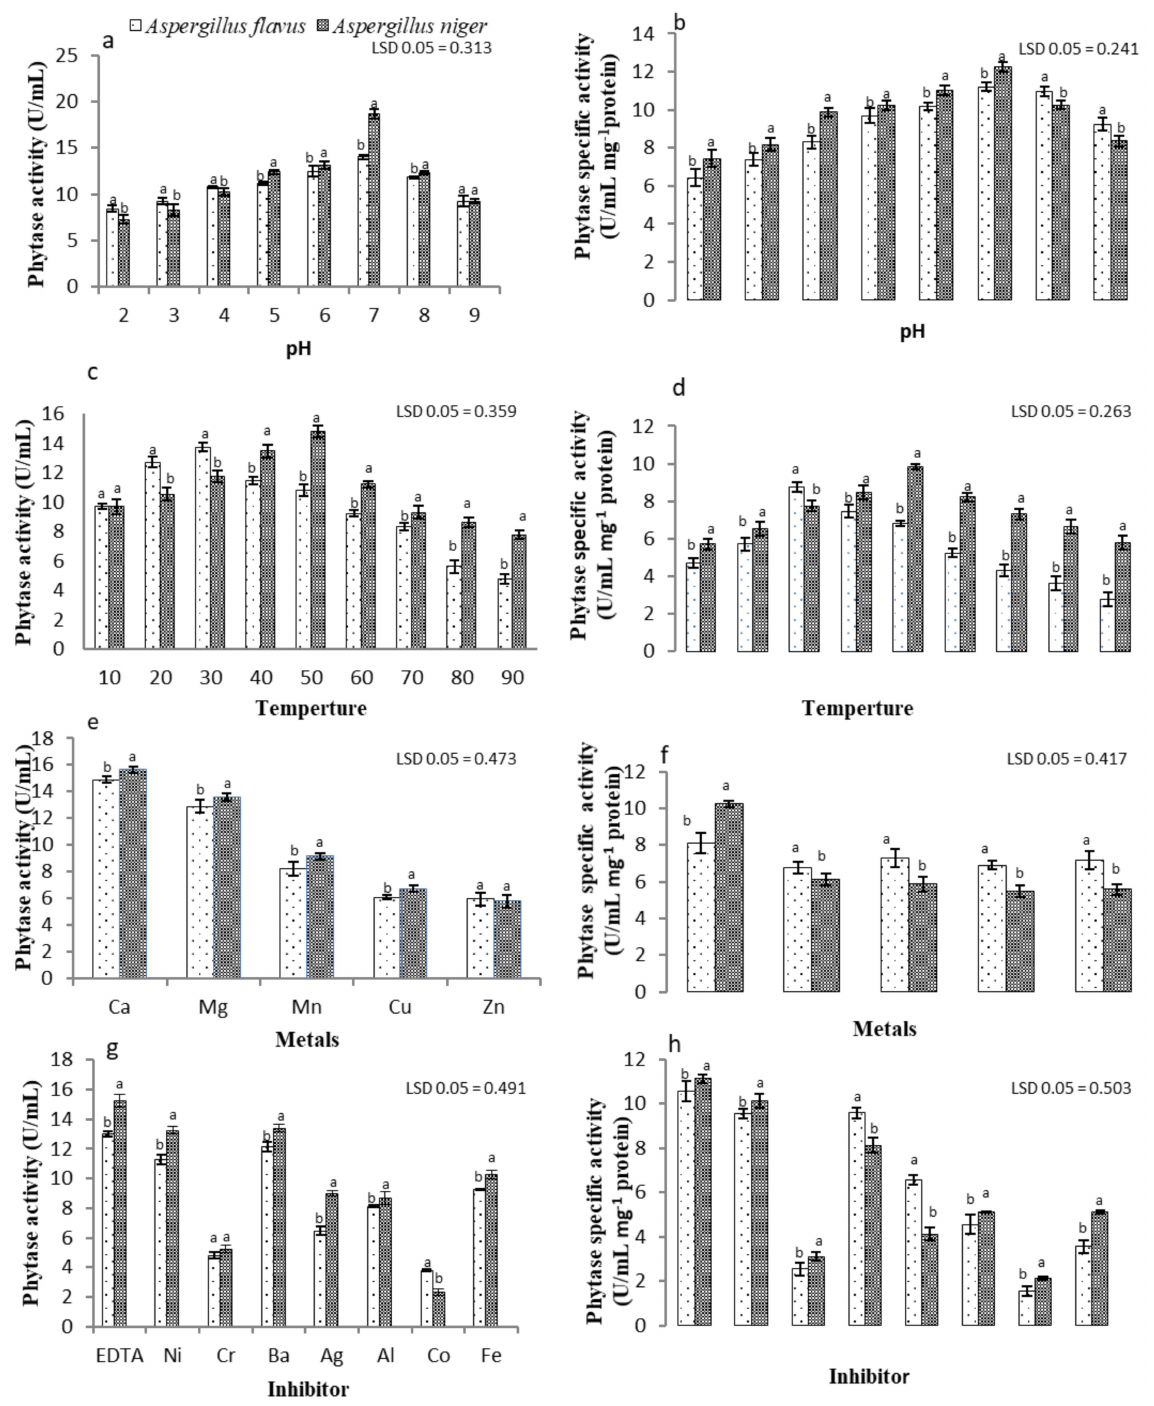
Figure 5. Stability analysis of crude phytase enzyme from two selected hyper producing fungal strains of Aspergillus flavus and Aspergillus niger under optimized eco-cultural conditions. The effects of different pH ( a , b ), temperature ( c , d ), addition of metal ions ( e , f ), and inhibitors ( g , h ) on phytase activity and phytase specific activity under standard assayed conditions. The given LSD value at 0.05 level refers to the significant differences among mean values of each